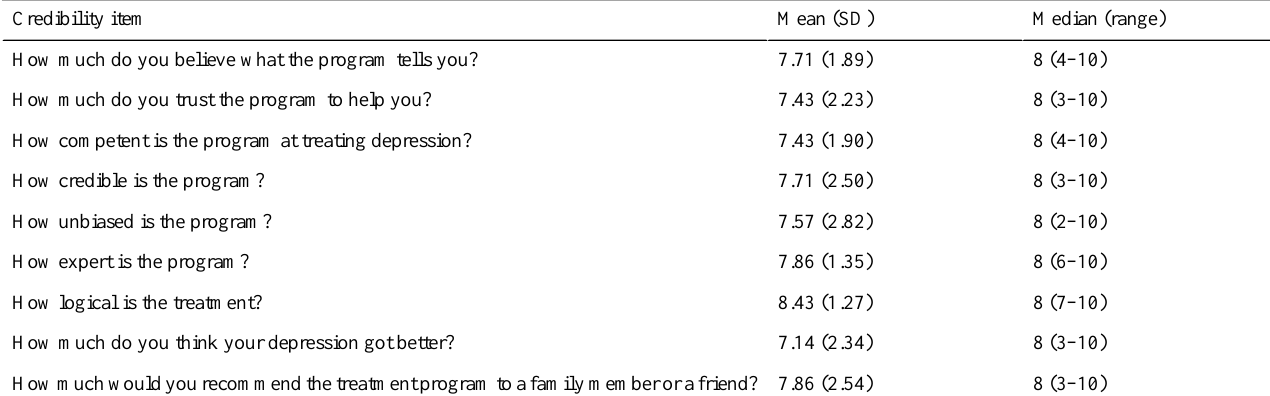
Table 2. Credibility Questionnaire scores (n =